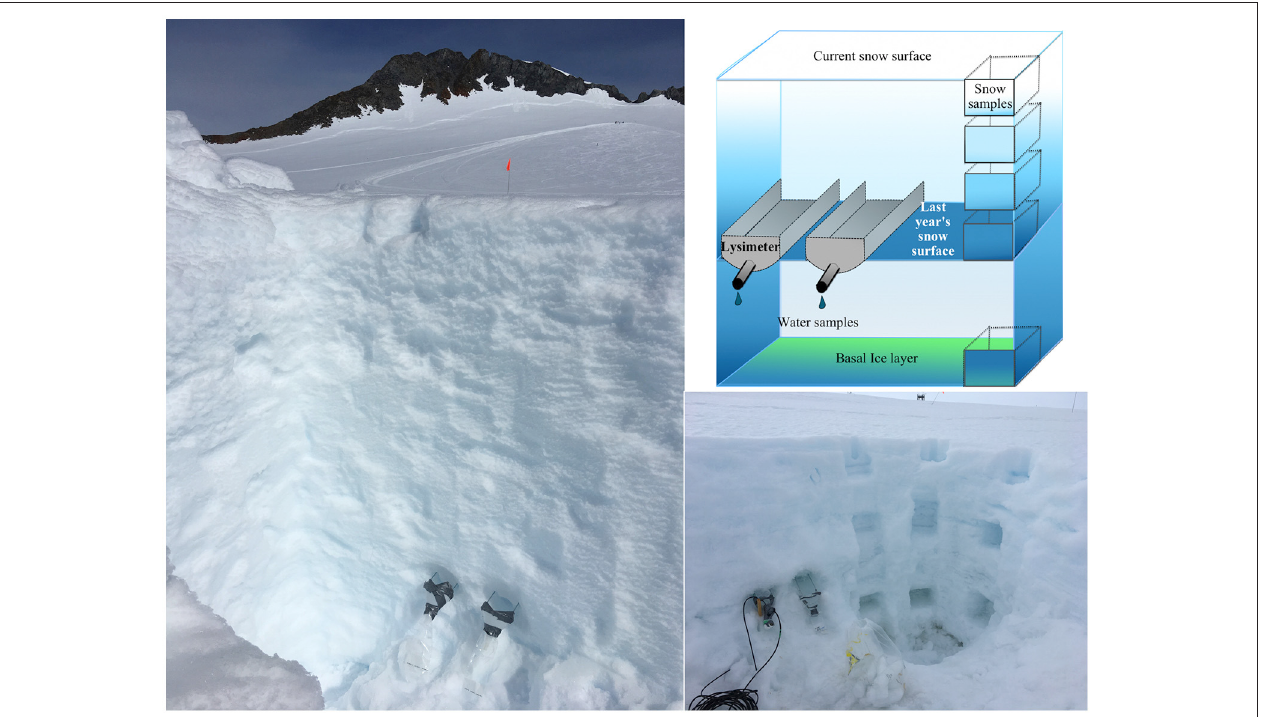
FIGURE 3 | Snowpack sampling design and execution at two monitoring sites, the Beach (right) and the Inland (left) . Photographs taken by Nowak A.